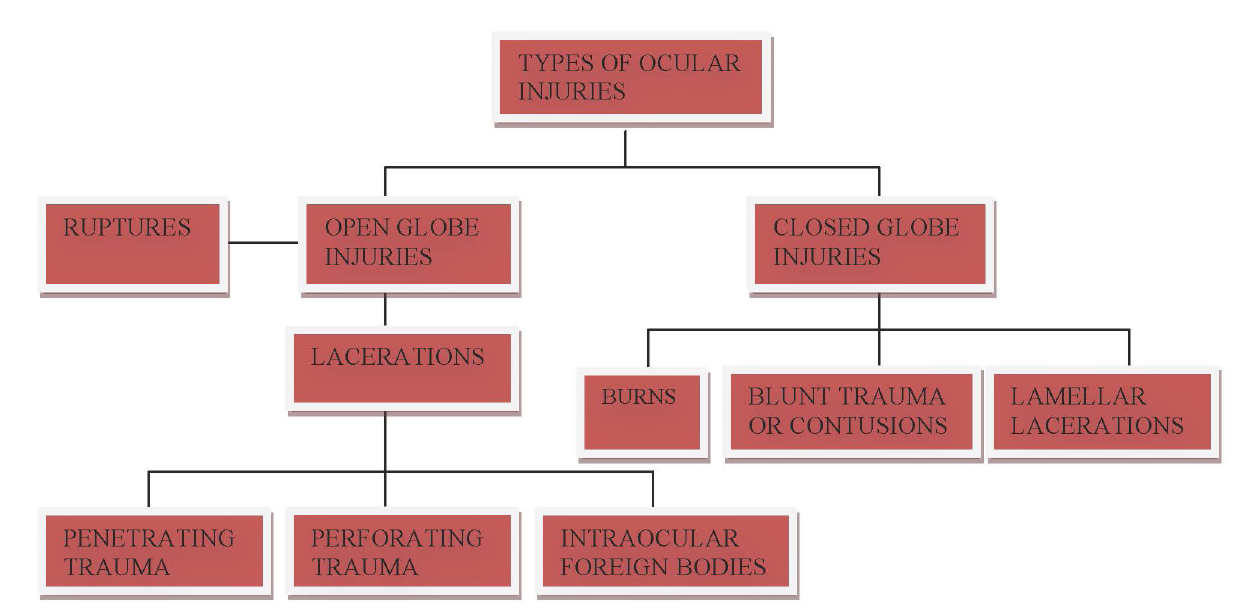
Figure 1: Standardized classification of ocular trauma using the Birmingham Eye Trauma Terminology (BETT) classification (Kuhn et al ,